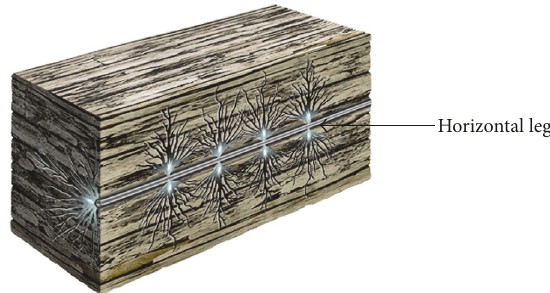
Figure 3: Horizontal wells are used in unconventional reservoirs because they provide larger area of contact with the formations. The horizontallegofthewellisperforatedandafluidunderconsiderably higher pressure is injected to stimulate the formation of fractures (adapted from http://fracfocus.ca/).